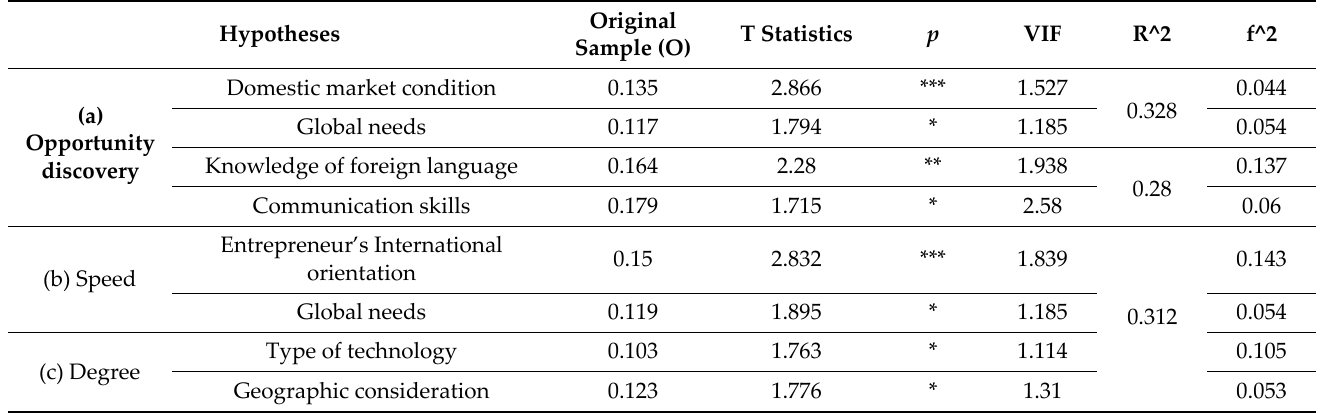
Table 3. Direct Effects.